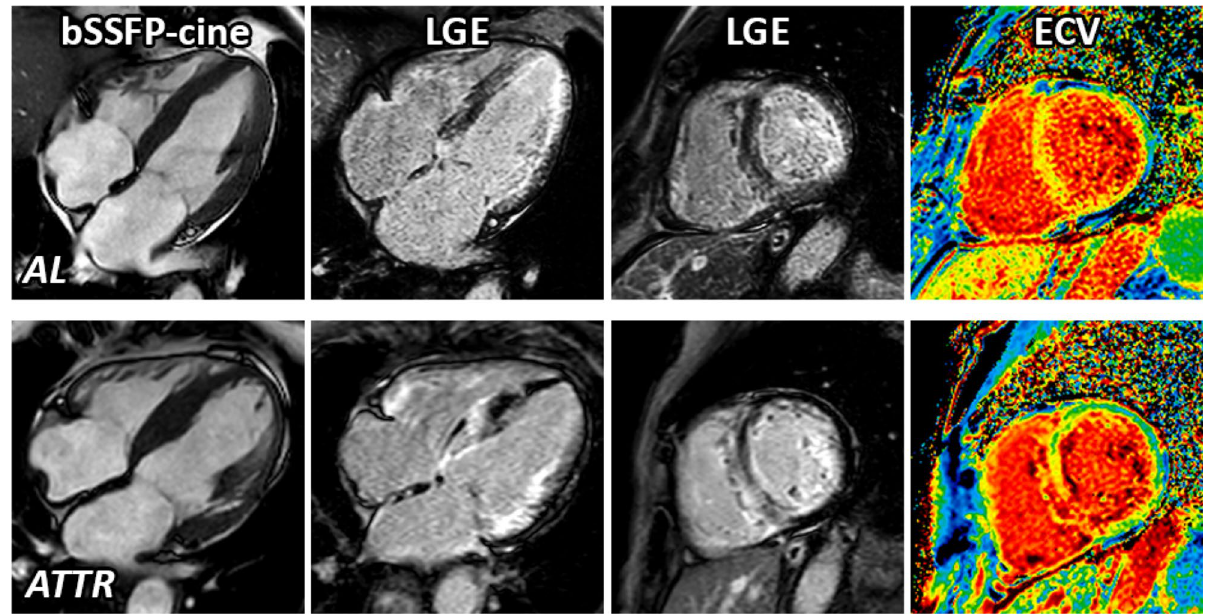
Figure 3. Example of cardiovascular magnetic resonance (CMR) images of AL amyloidosis (upper panel) and ATTRwt (bottom panel) showing cine-images in 4-chamber view in diastole, LGE in 4-chamber view, LGE in short axis as well as corresponding extracellular volume fraction (ECV) maps in a basal short-axis view respectively.